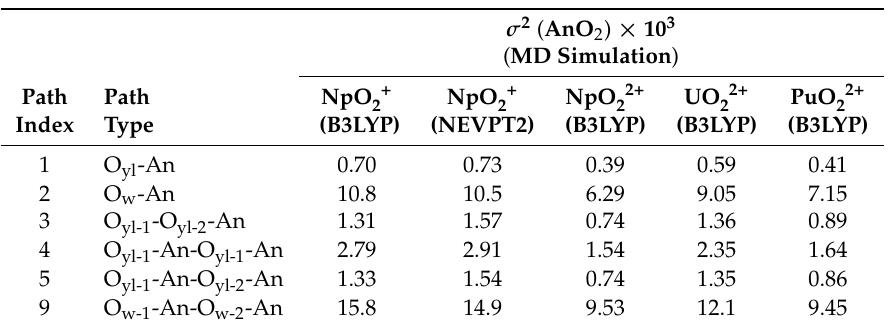
Table 2. DW factors of the main SS and MS paths of [AnO simulations (path description can be found in Figure 4). DW in Å